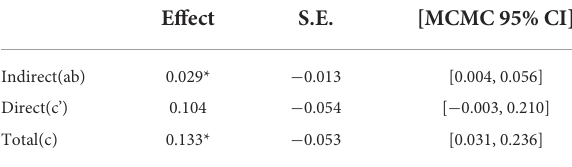
TABLE 4 Effects of mediation